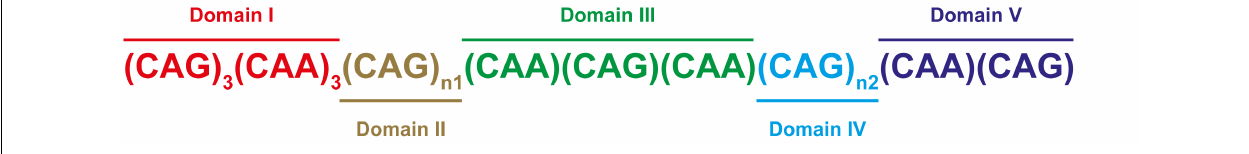
FIGURE 1 | CAG/CAA repeat configuration in the TBP gene. SCA17 is caused by CAG repeat expansion in the TATA-box binding protein gene ( TBP ). The repeat tract is characterized by CAA interruptions and has a typical configuration as shown, and can be segmented into Domain I (red), Domain II (brown), Domain III (green), Domain IV (blue), and Domain V (purple) (Gostout et al., 1993; Gao et al., 2008). Domains II and IV are polymorphic CAG repeats.